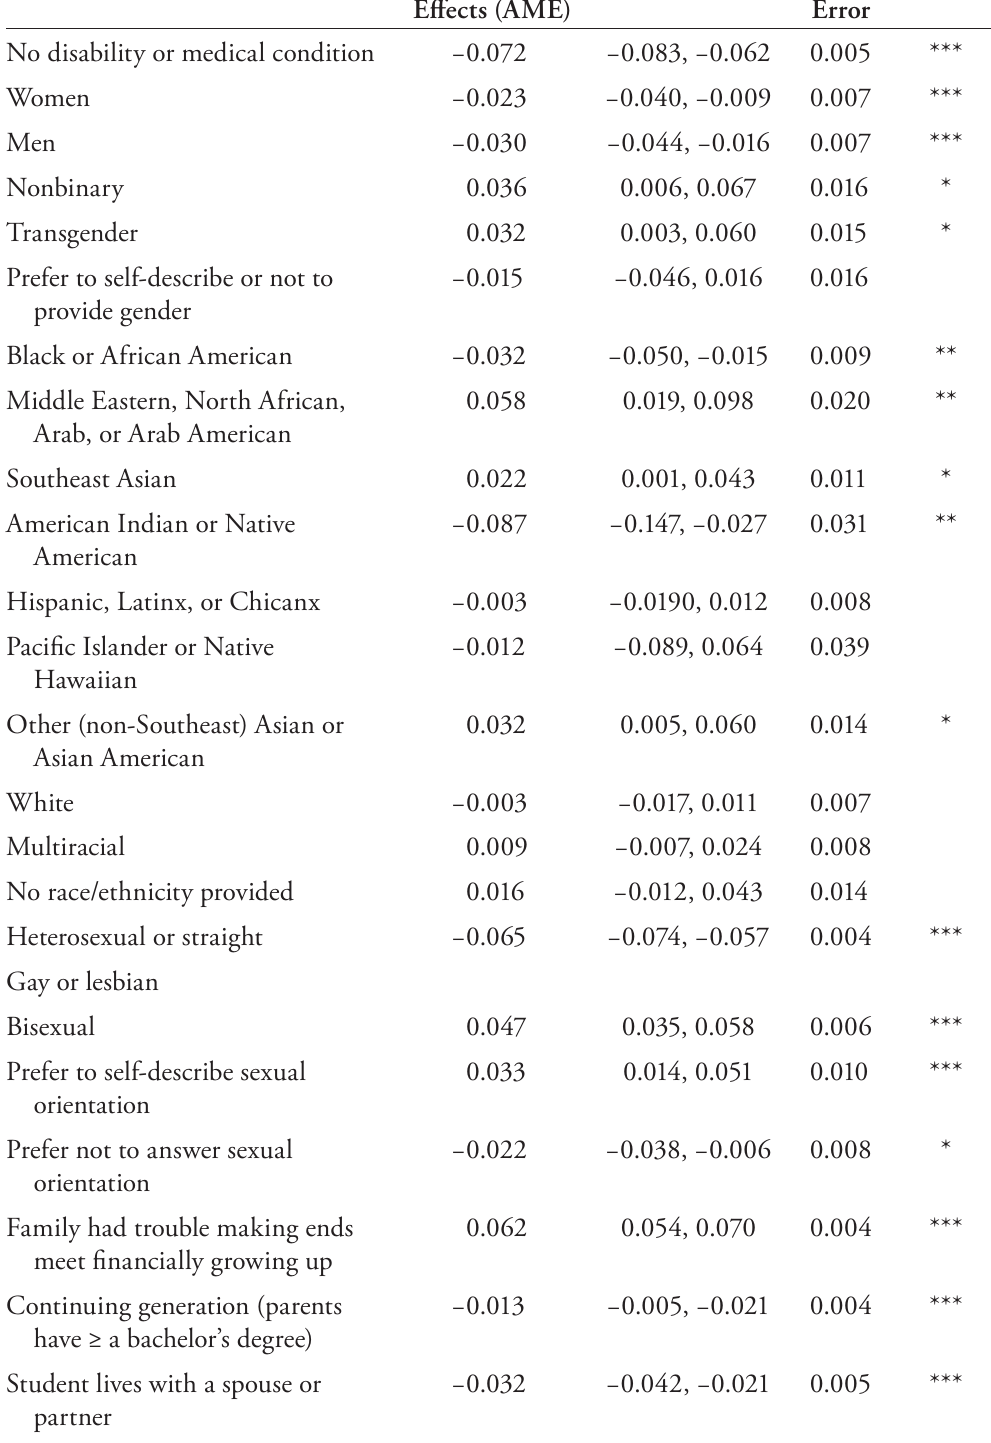
Table 2. Results of the Logistic Regression for Major Depressive Disorder (MDD) ( continued